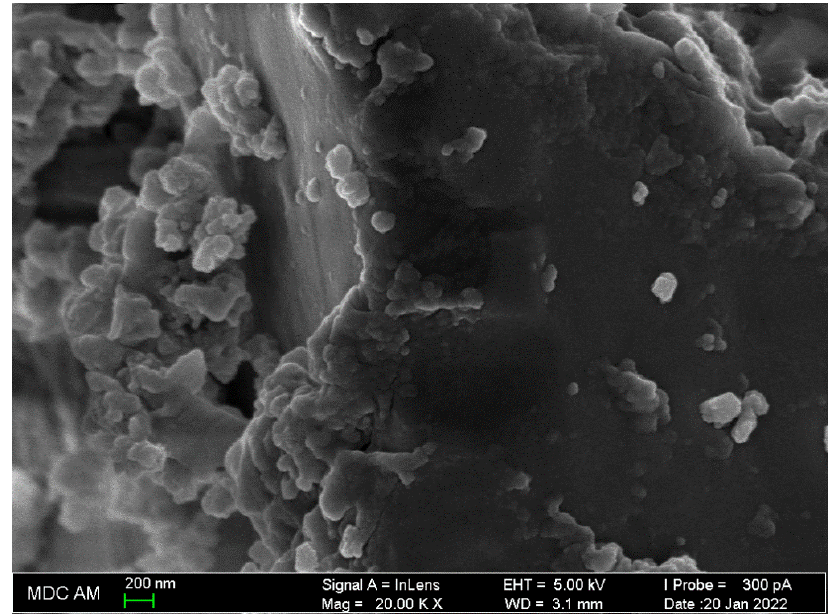
Figure 5. SEM analysis of the obtained catalyst after the pyrolysis process.